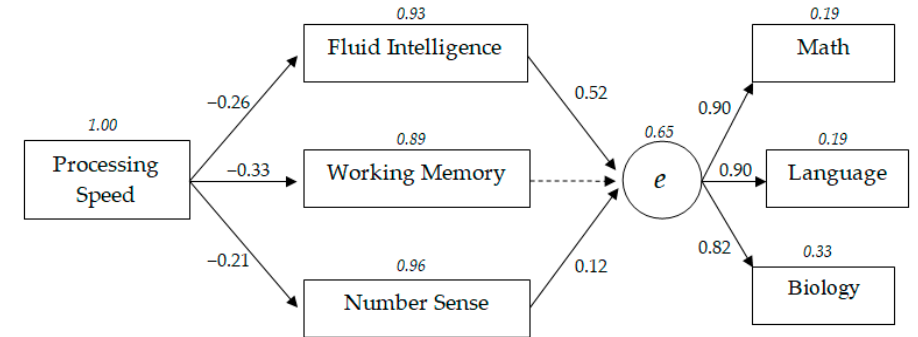
Figure 1. Model with relationships between cognitive abilities and general academic achievement in primary school education.